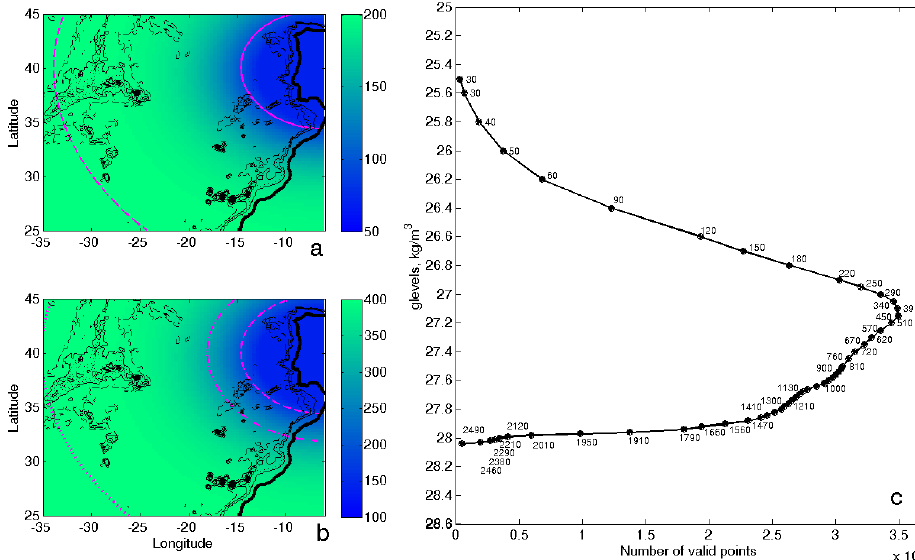
Figure 4. Spatial variation of R in (a) the upper 1900m layer, and (b) below 2000m. Isolines of 100km (magenta solid), 200km (magenta dashed), 300km (magenta dash–dotted) and 400km (magenta dotted) are added. (c) presents the total number of valid salinity data points at the selected neutral density surfaces. The numbers to the right of the black filled circles mark the area-mean depth of the neutral density surface in the study region (not all numbers are